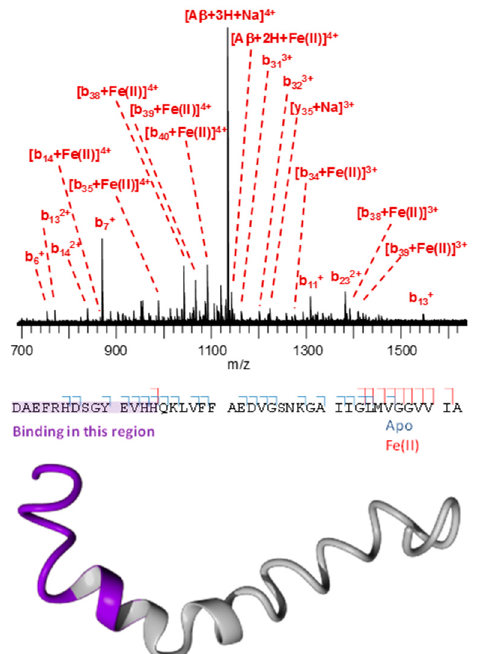
Figure 4. Collision-induced (CID) fragmentation of [A β + 2H + Fe(II)] 4+ . The fragments are summarized below the mass spectrum, and the possible binding region is indicated. A 3D structural representation of A β (1–42) is shown at the bottom, with the possible binding region colored purple.